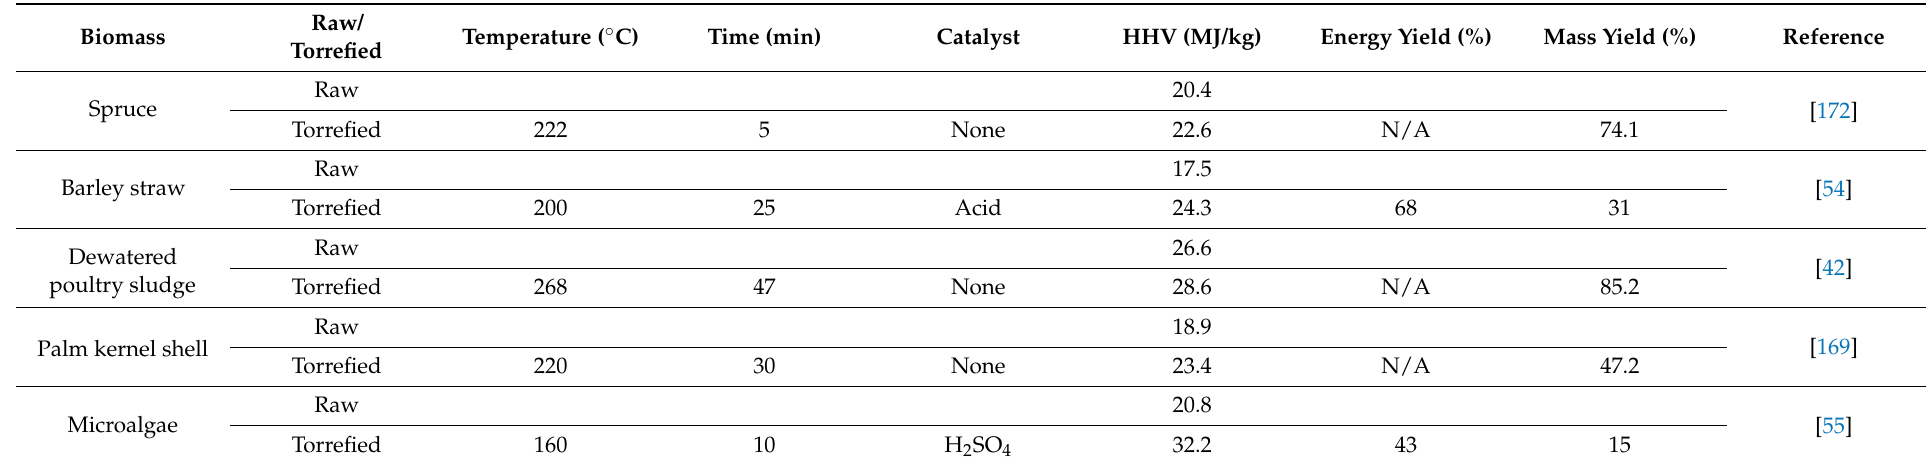
Table 6. Raw and wet-torrefied lignocellulosic feedstock’s high heating value, and mass/energy